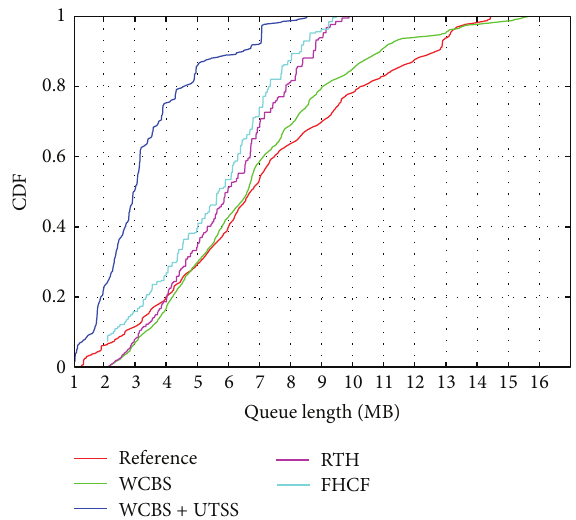
Figure 16: CDF of HCCA buffer length in the case of VS3